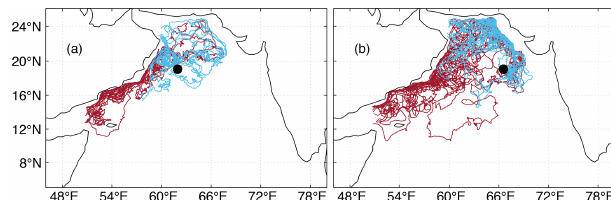
Figure 6. Exemplary advective Lagrangian pathways connecting the Persian Gulf (blue) and the Red Sea (red) with the (a) west- ern release (WR) and the (b) eastern release (ER) locations marked in black.